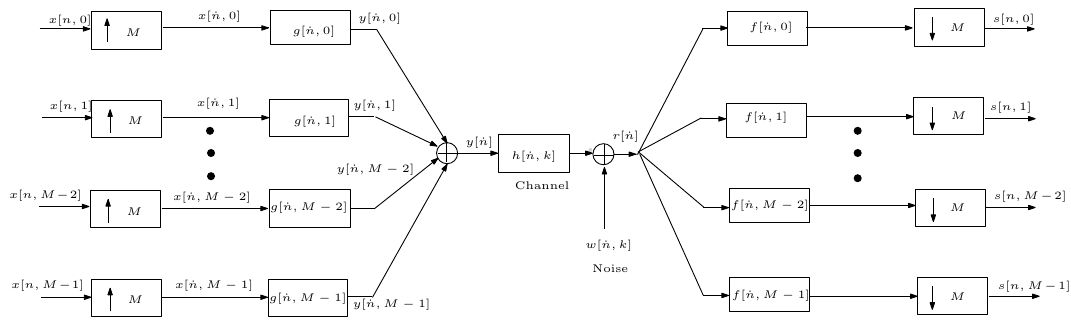
Figure 5. Basic structure of FBMC based transceivers.